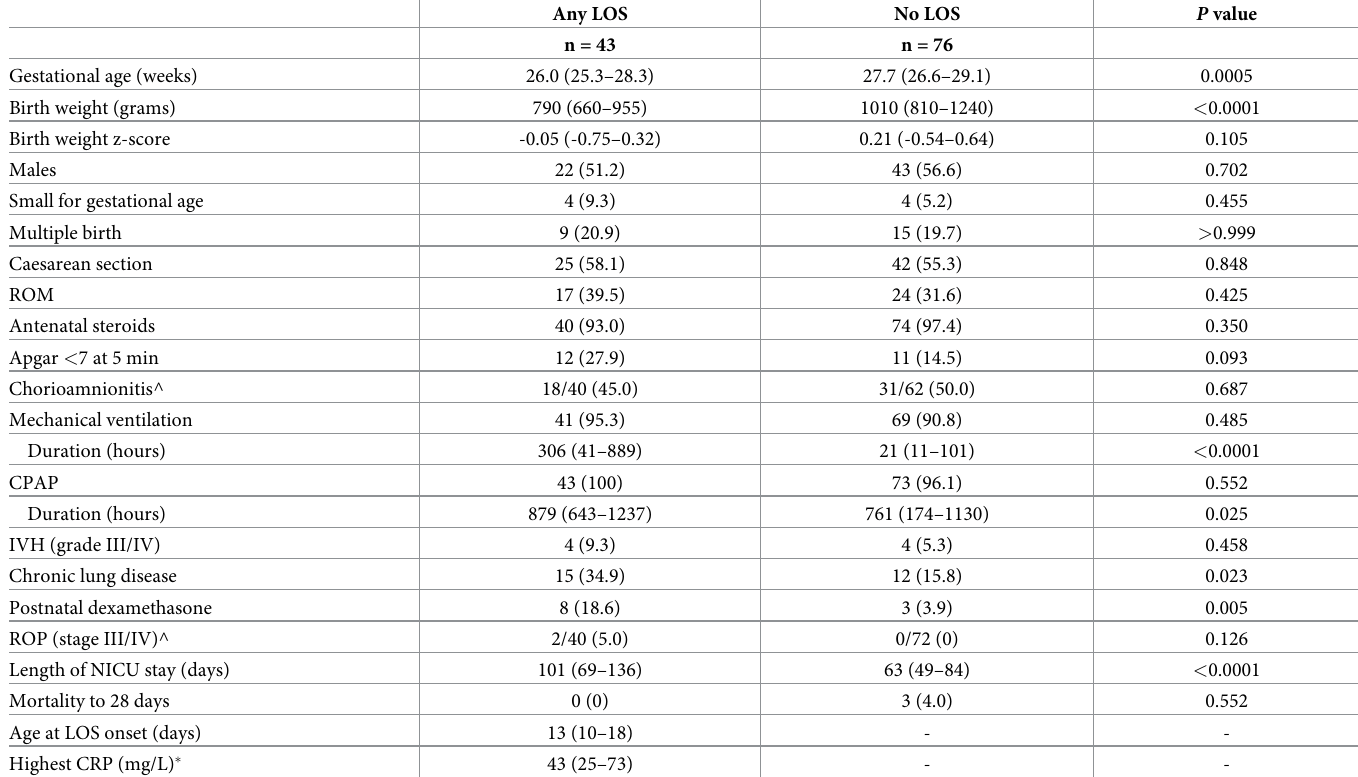
Table 1. Basic clinical characteristics of the study